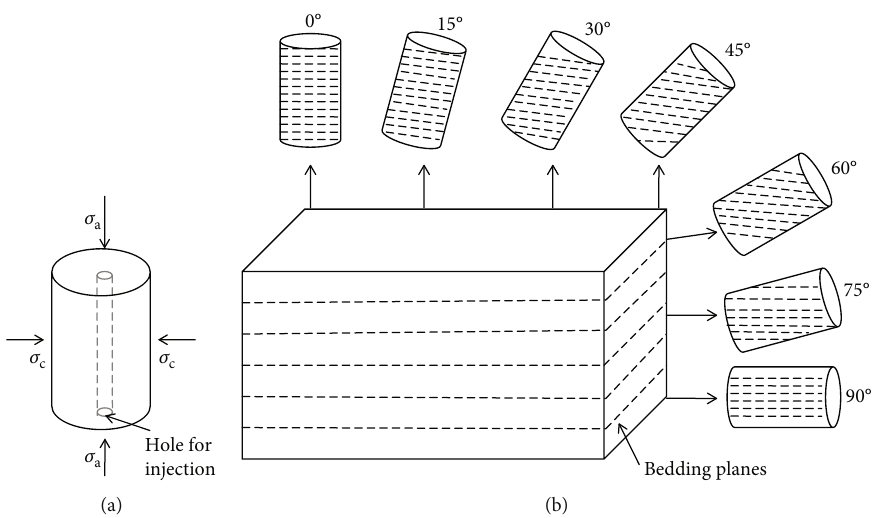
Figure 1: Diagram of (a) sample with injection hole and (b) sample with di ff erent bedding